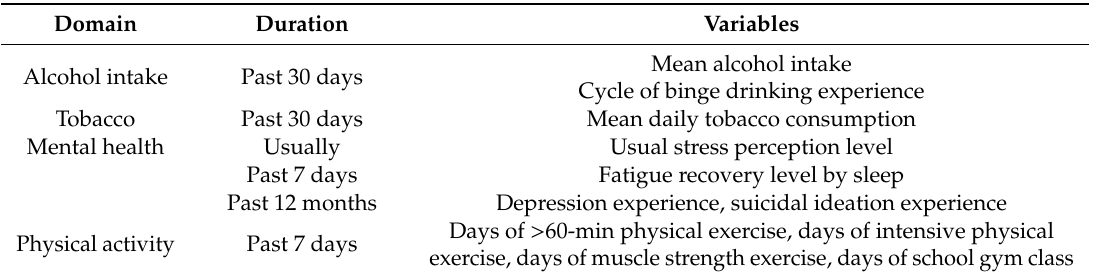
Table 1. Health-risk behaviors and mental health and physical exercise factors related to tooth fracture experience from the 14th Korea Youth Risk Behavior Survey in 2018.